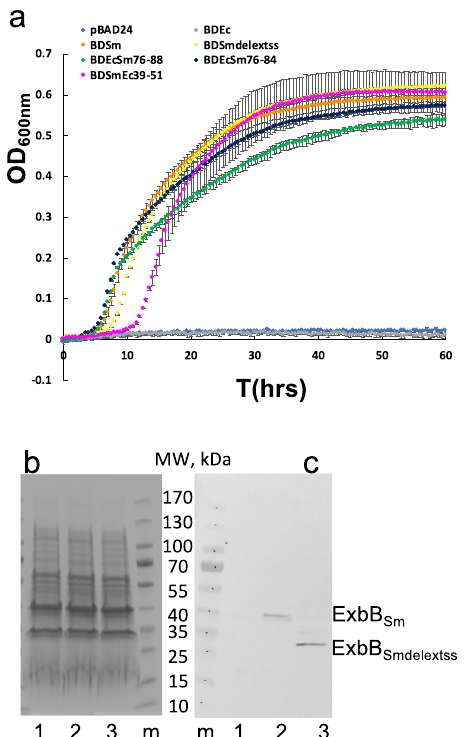
Fig. 5 ExbB TM1 interacts with HasB. a bacterial growth curves of E. coli C600 Δ hemA Δ exbBD Δ tonB harboring pAMHasISRADEB plasmid together with either pBAD24 (medium blue), pBADExbBD Sm (orange) or pBADExbBD Smdelextss (yellow), pBADExbBD Ec (gray), pBADExbBD EcSm76-88 (green), pBADExbBD EcSm76-84 (dark-blue), pBADExbBD SmEc39-51 (magenta) in the presence of 1 µ M He-BSA as heme source, 4 µ g/ml arabinose to induce ExbBD expression and 40 µ M dipyridyl to induce iron starvation (see Materials and Methods for further details). The optical path was ca. 3 mm long, and each curve represents the mean of four replicates of the same culture, recorded every 30 min for 66 h. The error bars are calculated as the standard error of the four measurements. Coomassie-blue stained gel ( b ) and immunodetection ( c ) with anti-His6 antibody of membrane preparations of E. coli C600 harboring either pBAD24 plasmid (1), pBADExbB Sm (2) or pBADExbB Smdelextss (3). The equivalent of 0.6 OD 600nm was loaded in ( b ), and of 0.3 OD 600nm in ( c